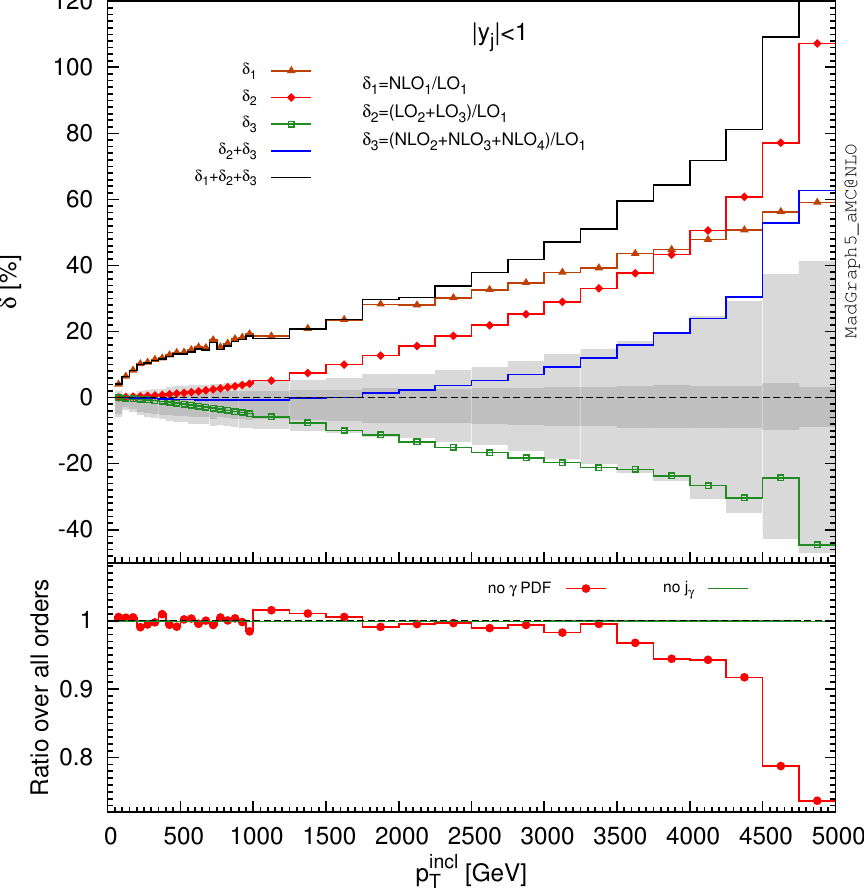
Figure 5 . Single-inclusive transverse momentum, for j y j (cid:20)